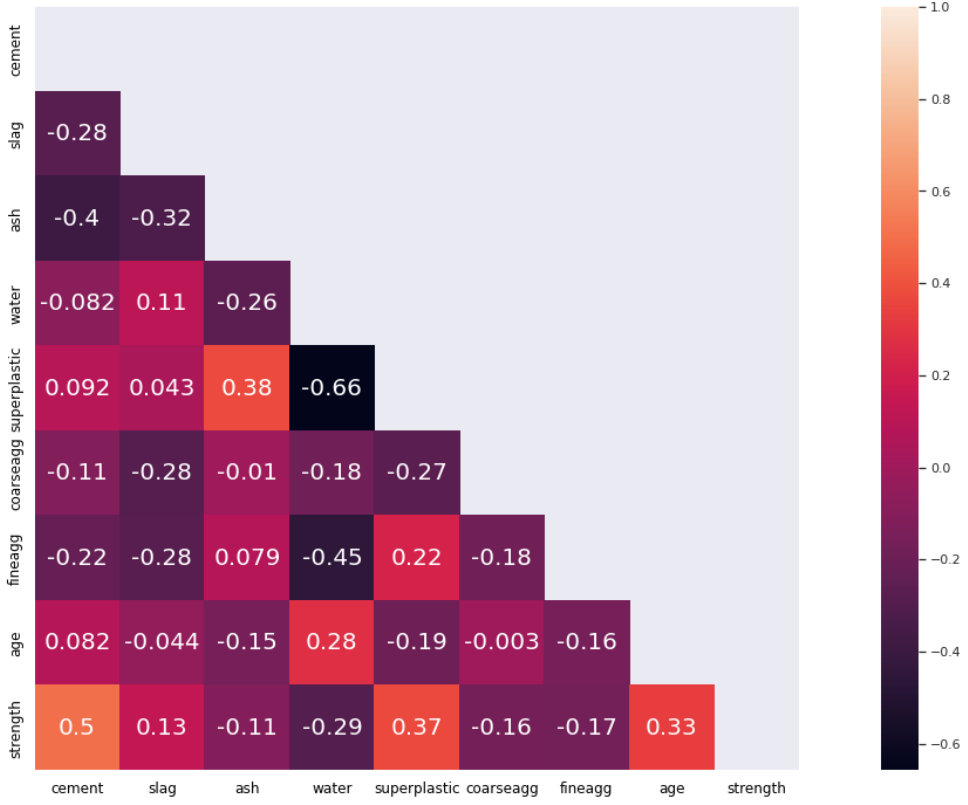
Figure 2. Heat map of correlation matrix of the input variables.